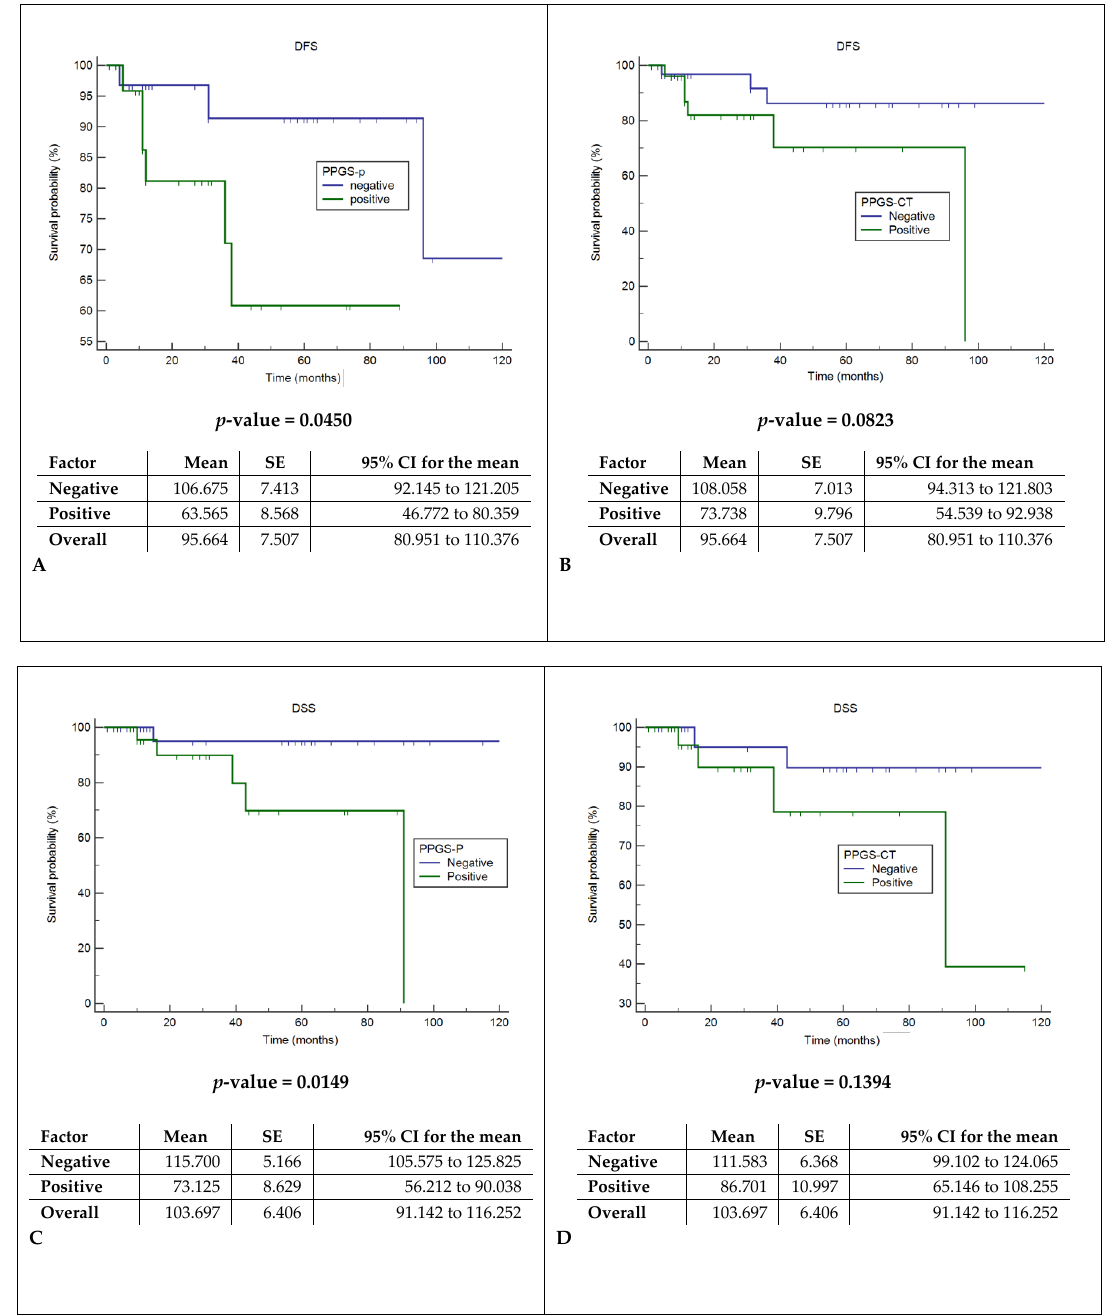
Figure 5. Disease-free survival (DFS) and disease-specific survival analysis (DSS). ( A ) Comparison of DFS between the histopathological assessment of spared or involved pPGS. ( B ) Comparison of DFS between the radiological assessment of spared or involved pPGS. ( C ) Comparison of DSS between the histopathological assessment of spared or involved pPGS. ( D ) Comparison of DSS between the radiological assessment of spared or involved pPGS. pPGS: posterior paraglottic space, SE: standard error and CI: confidence interval.